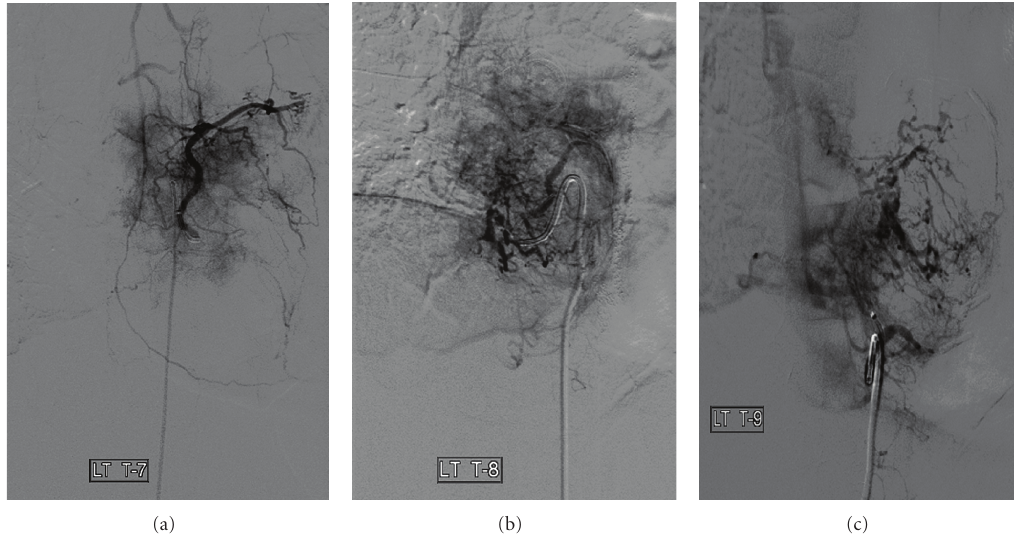
Figure 2: Before TACE with irinotecan-eluting beads. Selections of the (a) left T7 intercostal artery, (b) left T8 intercostal artery, and (c) left T9 intercostal artery. Note the small branches from these intercostal arteries supplying the spinal metastasis from colorectal cancer.